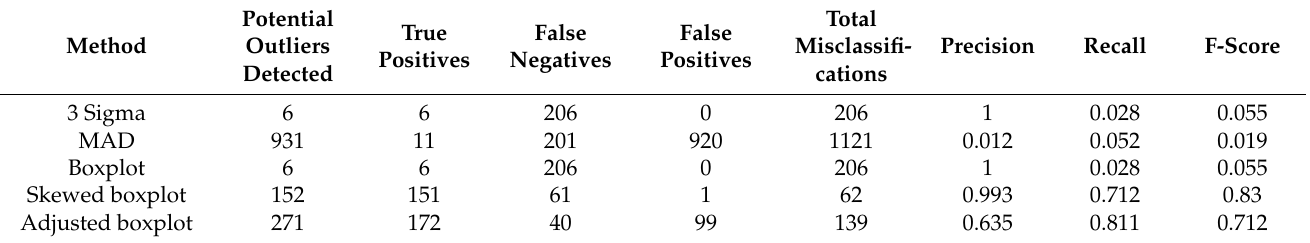
Table 7. Outliers found in the global search by each method on real data.